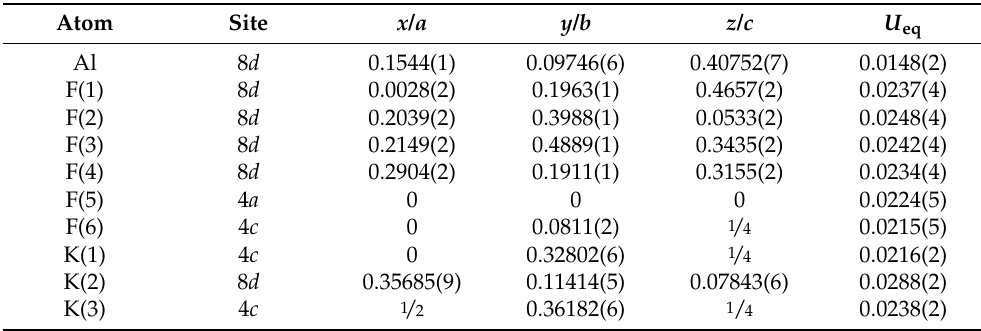
Table 2. Fractional atomic coordinates and equivalent isotropic displacement parameters (in 10 4 pm 2 ) for K 2 AlF 5 -2.